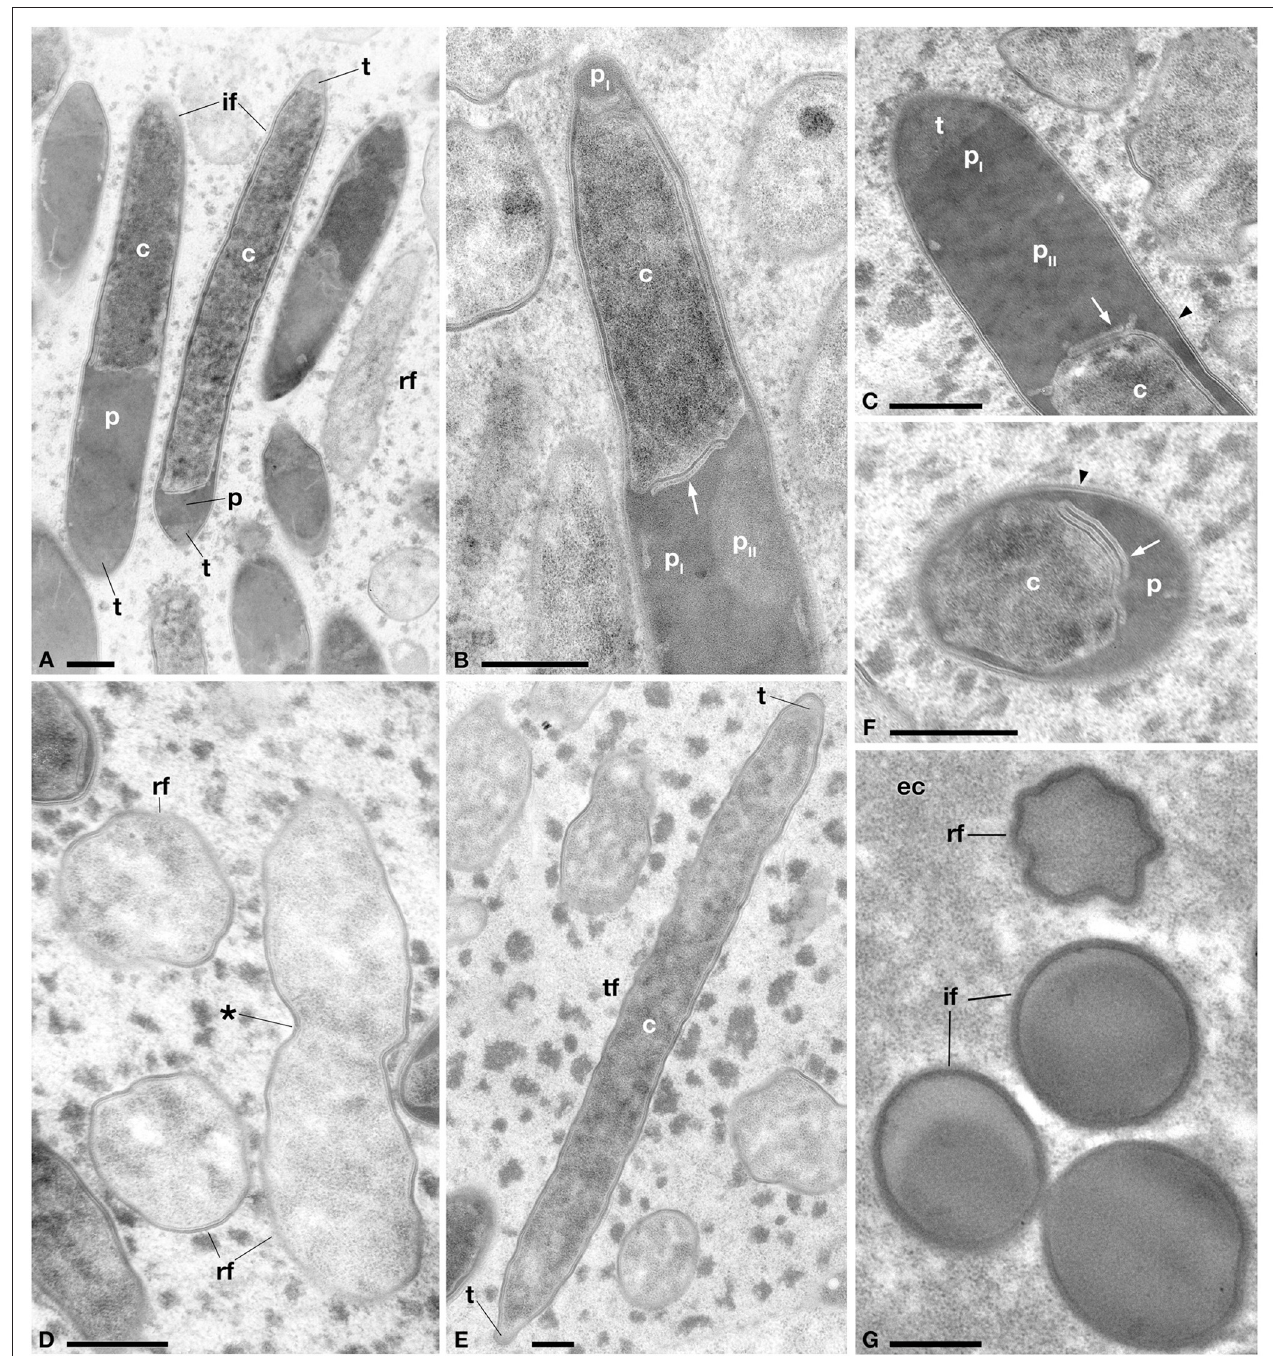
FIGURE 4 | Ultrastructural morphology of the novel Holospora -like bacteria harbored by P. multimicronucleatum , after 1 year of cultivation. (A) Longitudinal section of reproductive ( rf ) and infectious ( if ) forms, the latter showing various degrees of cell compartmentalization in cytoplasm ( c ), periplasm ( p ) and recognition tip ( t ). (B) Detail of if showing cytoplasmic extrusion and periplasm with two electron-dense areas, a darker ( p I ) and a lighter ( p II ) one. (C) Detail of t , p I , and p II in if . (D) rf in transverse section and in longitudinal section during binary fission. (E) Transient form ( tf ) in longitudinal section with t at both ends of cellular body. (F) Transverse section of if showing irregular distribution of p around cytoplasmic part. (G) Transverse section of if and rf inside eukaryotic cytoplasm ( ec ) of host. Arrows indicate cytoplasmic extrusion in periplasmic space, arrowhead indicates the membrane layers surrounding IF. The asterisk indicates the cleavage furrow. Bars stand for 0.5 µ m.